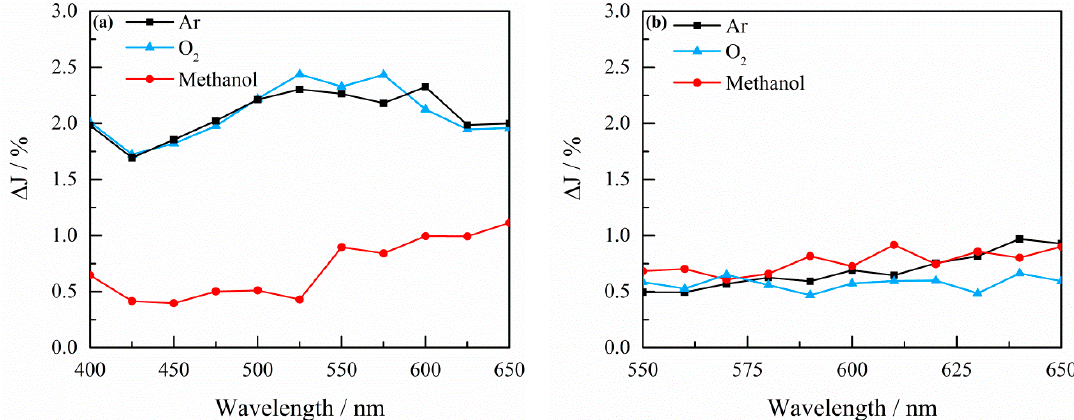
Figure 4. Transient absorption spectra of K-7000 measured 100 ns after excitation with a ( a ) 355 nm and ( b ) 455 nm laser in Ar (black), O 2 (blue), and methanol (red) atmospheres.